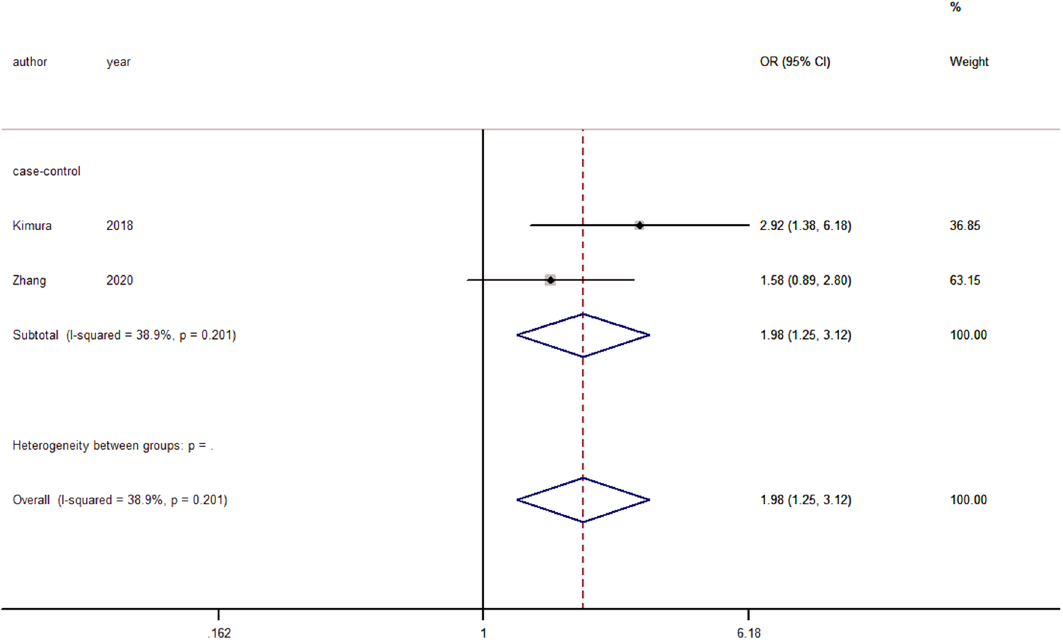
Figure 8. Forest plot showing the effect of smoking on axial neck pain. OR, odd rate; RR, risk rate; CI, confidence